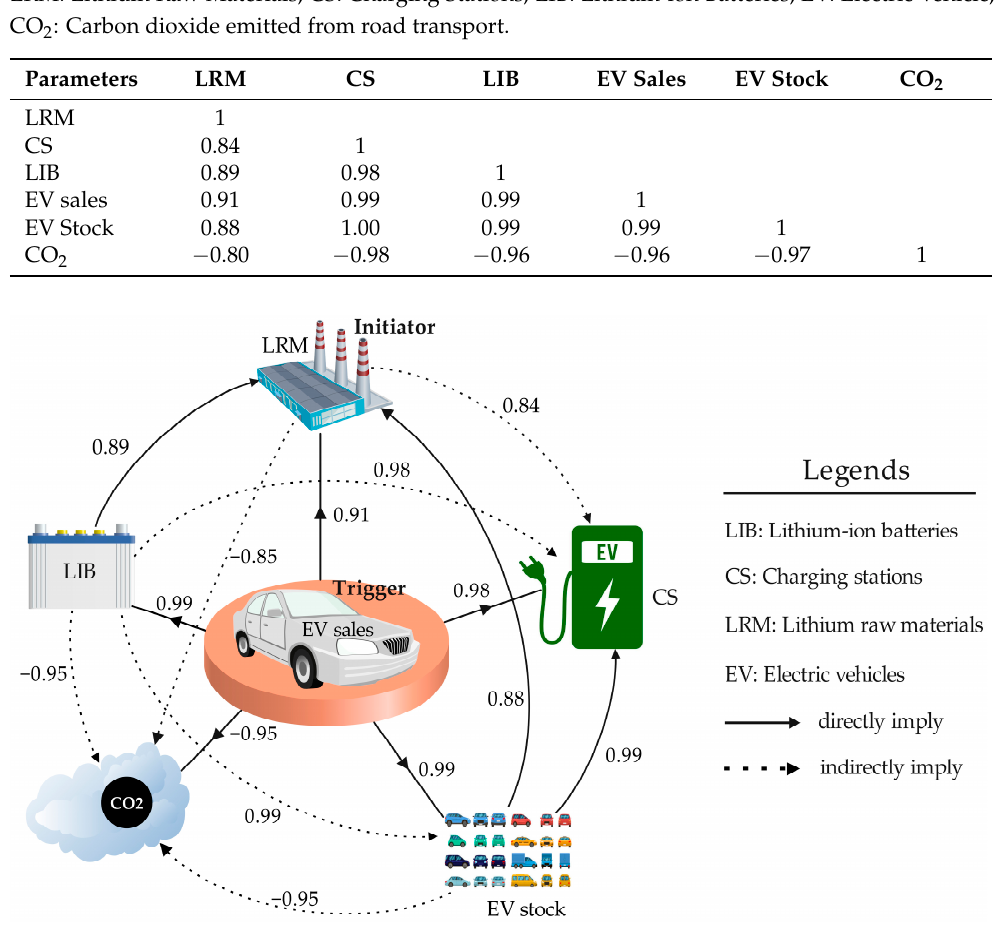
Figure 5. Relationship between element compositions of the EV manufacturing cycle. Numbers indicate the correlation coefficient between parameters. Here, all six (6) variables involved in the cycle, which are LIB, CS, LRM, EV